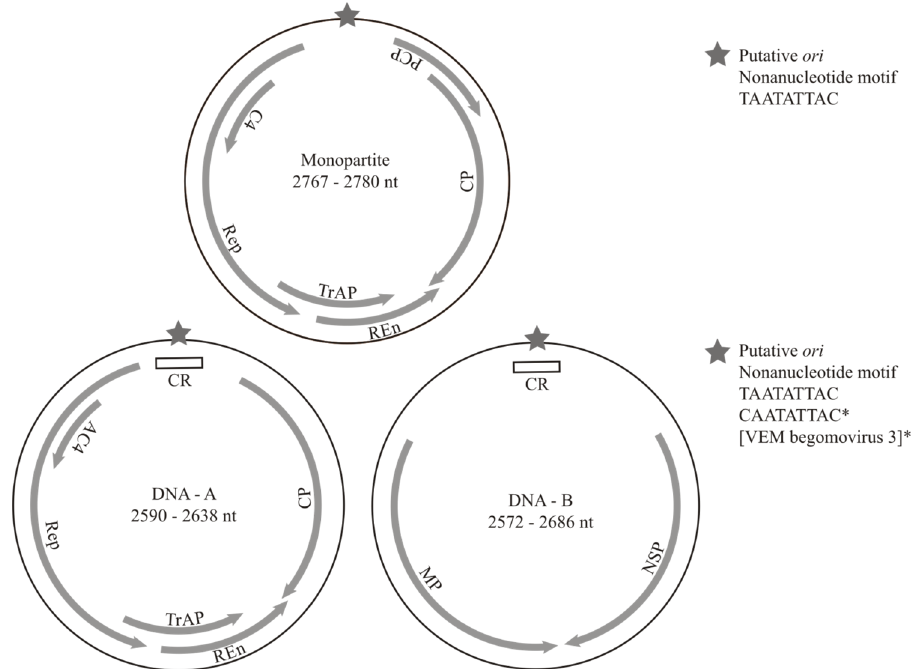
Figure 1. Schematics depicting general genome organization and features observed in novel begomoviruses. All genomes are characterized by a putative origin of replication ( ori ) marked by a stem-loop structure containing a conserved nonanucleotide motif. Begomovirus genomes can be monopartite or bipartite and encode capsid (CP), replication-associated (Rep), transcriptional activator (TrAP), replication enhancer (REn), and virulence factor (C4 or AC4) proteins. Old World begomoviruses also encode a precoat protein (PCP). The DNA-B component of bipartite begomoviruses encodes nuclear shuttle (NSP) and movement protein (MP) proteins.